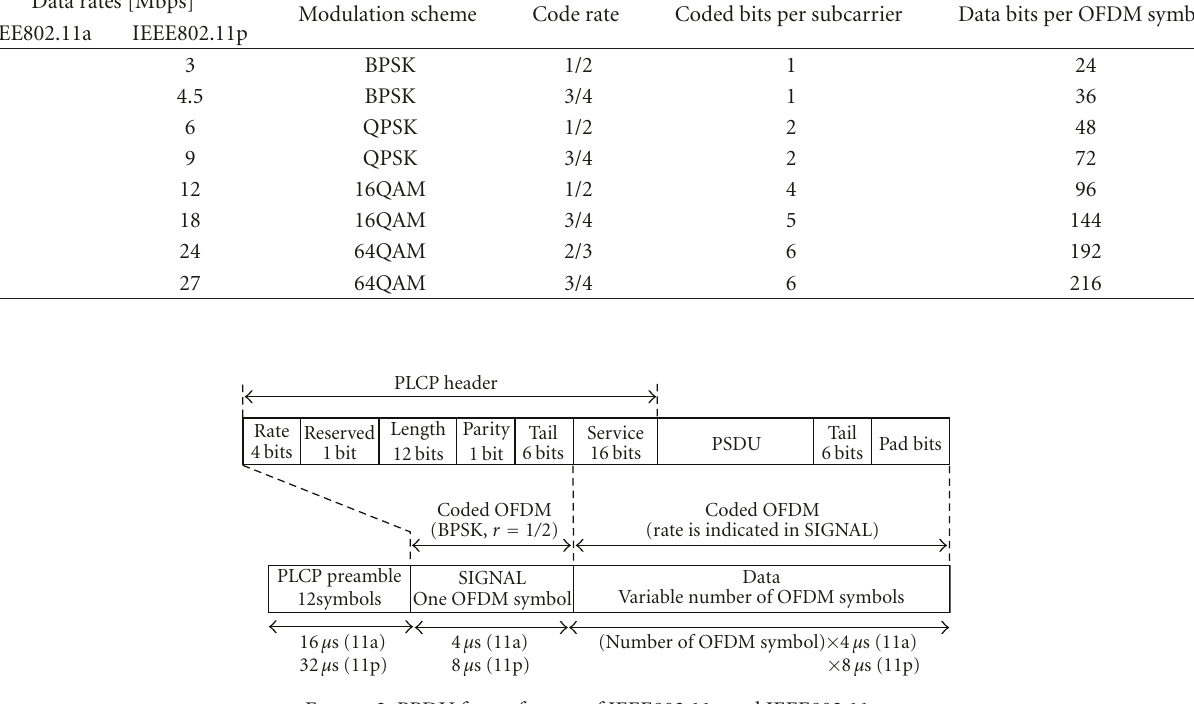
Figure 2: PPDU frame format of IEEE802.11a and IEEE802.11p.